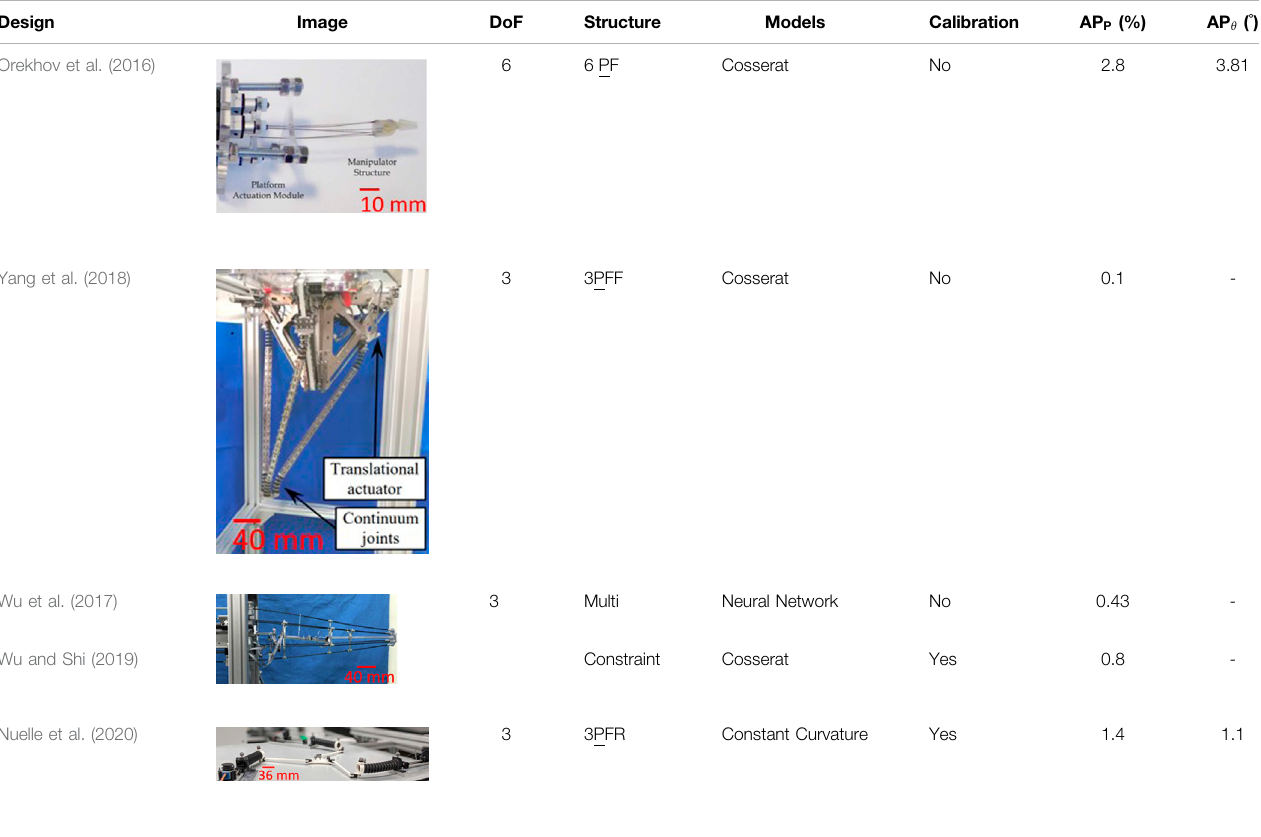
TABLE 1 | Mean orientation AP θ and positioning accuracy AP P (in percent of the nominal or mean dimension of the continuum fl exible segment) for different PCR designs.